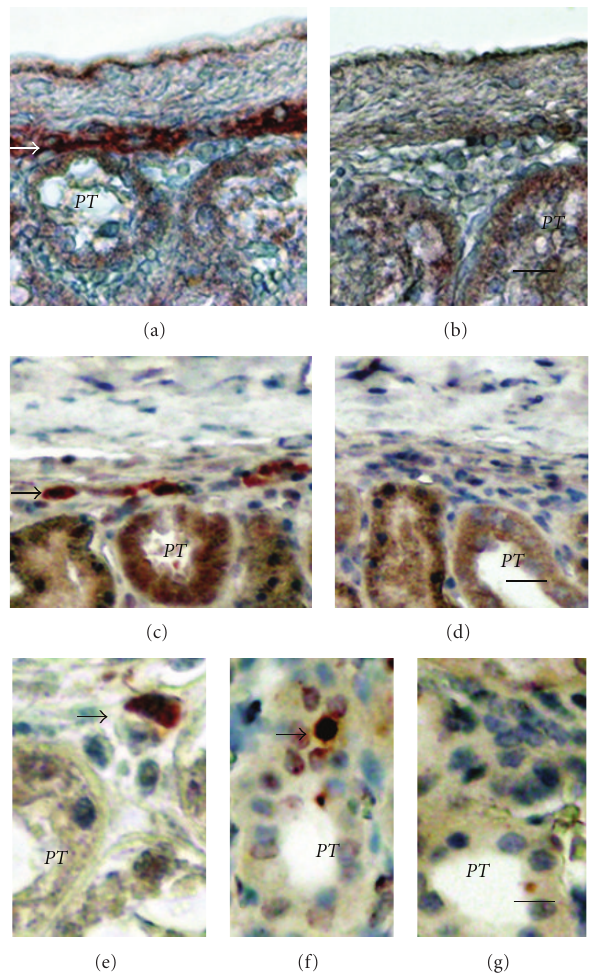
Figure 1: Sections of the islet-implanted kidney from a rat (a, b) or rhesus macaque (c–g) transplanted with E28 pig pancreatic primordia in mesentery followed by porcine islets in the renal subcapsular space stained using anti-insulin antibodies (a, c, and e) or control antiserum (b, d); or hybridized to an antisense (f) or sense (g) probe for porcine proinsulin mRNA. PT: proximal tubule. Arrows: positively staining cells (a, c, and e). Scale bars 10 um (a, b); 15 um (c, d), 7.5um (e–g). Reproduced with permission from the American Society for Investigative Pathology [7] and from Organogenesis